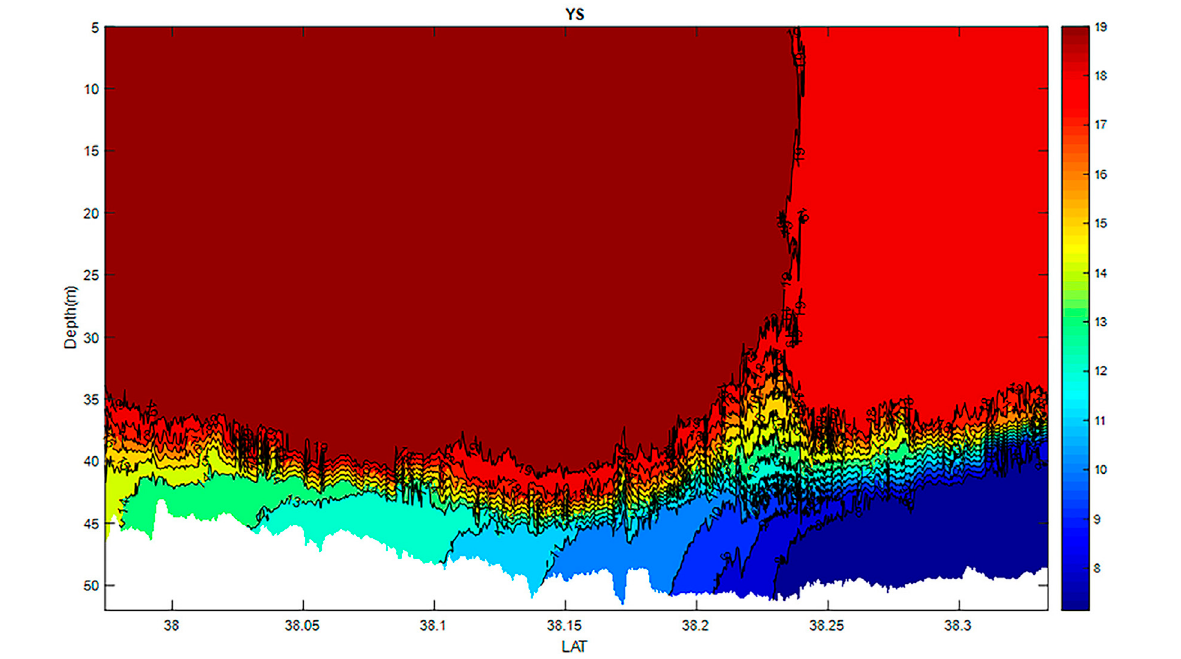
Frontiers in Physics |